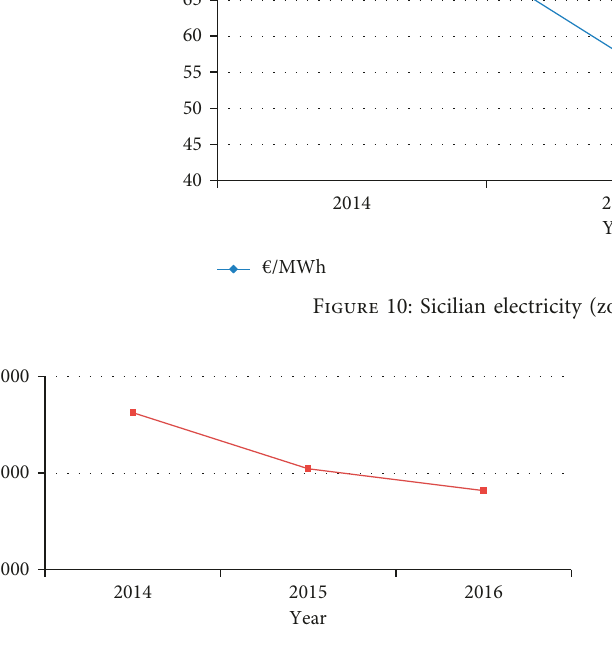
Figure 11: Sicilian HHI value (period